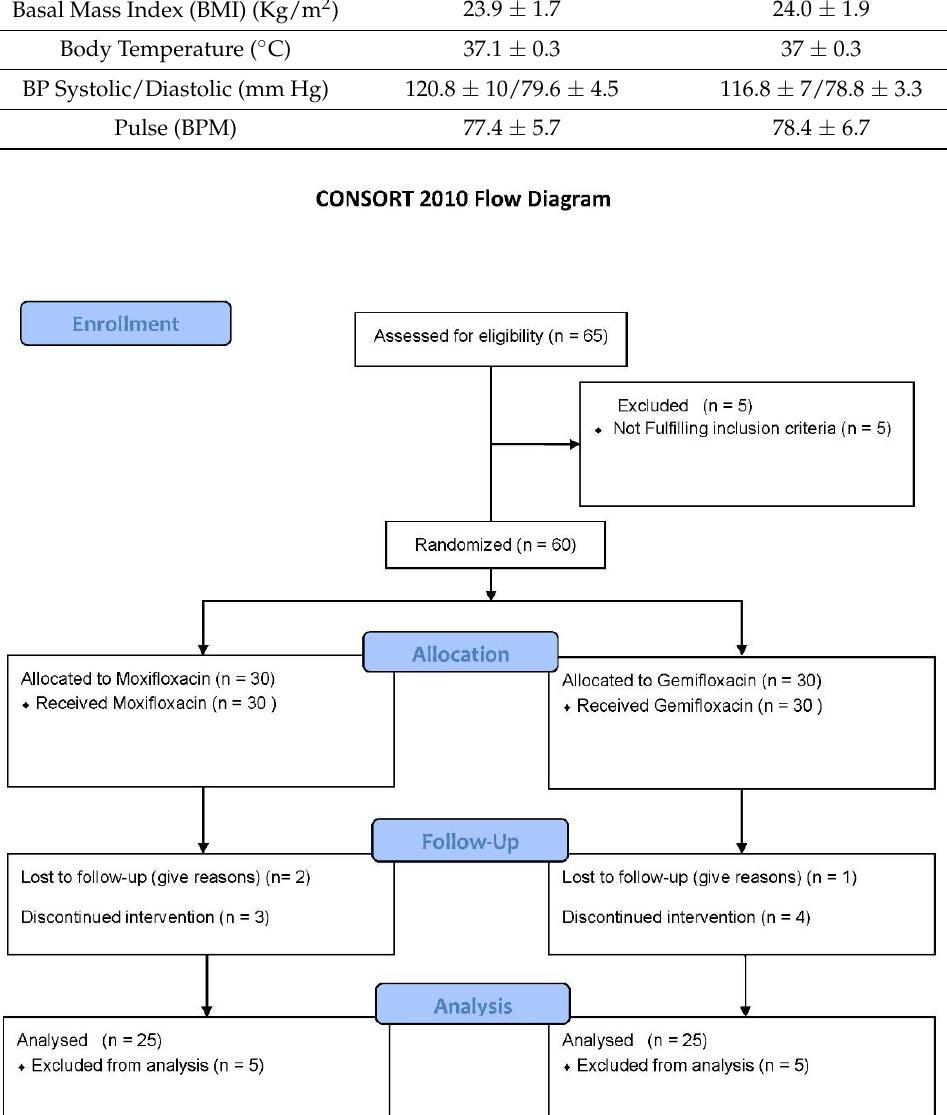
Figure 1. Clinical Trial Profile.